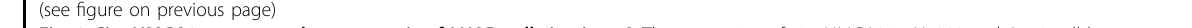
Fig. 3 Circ ‐ HMGA2 promotes the metastasis of LUAD cells in vitro. A The expression of circ-HMGA2 in H1299 and A549 cell lines was signi fi cantly reduced after transfection with siRNA. B , C The results of transwell assays showed that the metastatic ability of H1299 and A549 cells was decreased after the circ ‐ HMGA2 knockdown. Scale bar: 200 μ m. D The results of wound healing experiments showed that the migration of H1299 and A549 cells was decreased after circ ‐ HMGA2. Scale bar: 200 μ m. E Circ-HMGA2 was signi fi cantly overexpressed in H1299 and A549 cells. F , G The